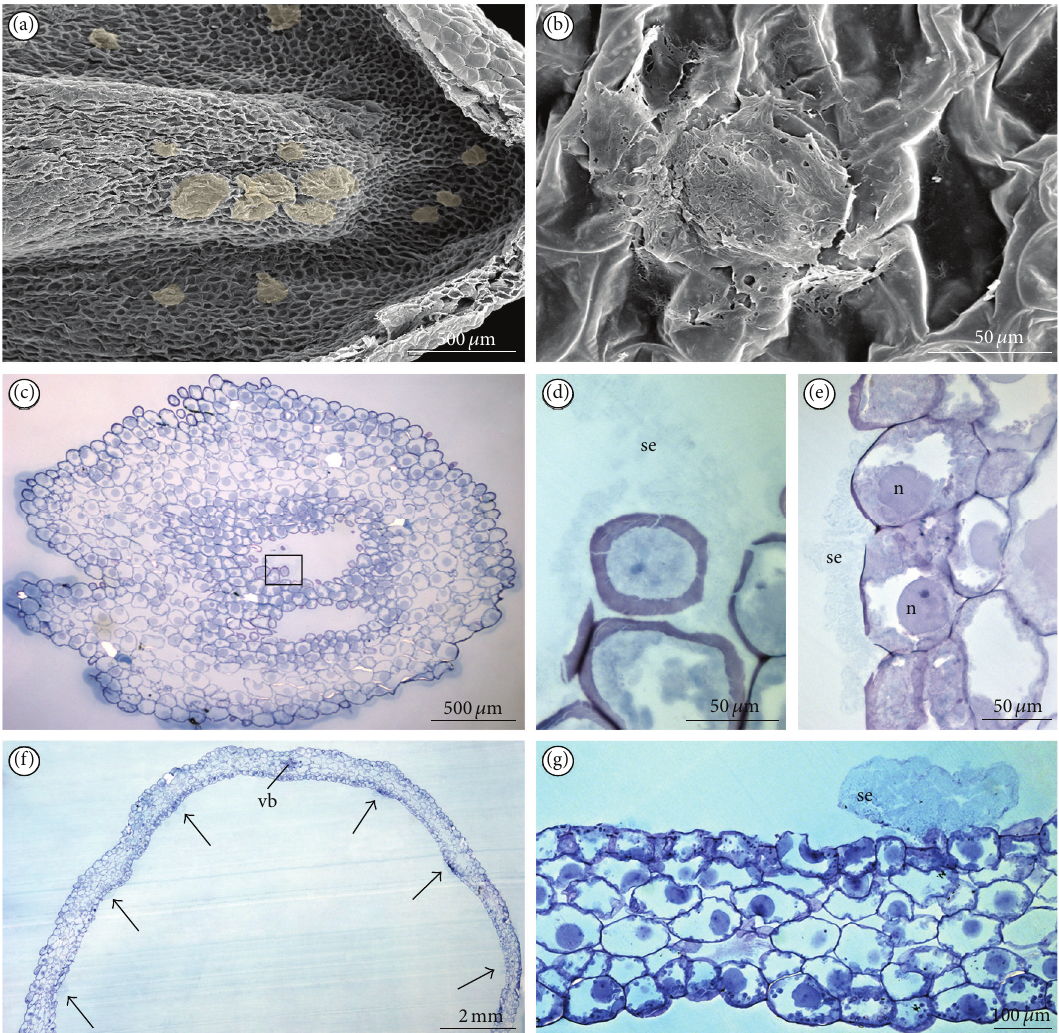
Figure 5: Lip spur, 4th day of anthesis: (a) surface of adaxial (inner) part of spur with places of secretion ( yellow ) (SEM). (b) Secretion in the apex of the spur (SEM). (c) Cross-section of spur, the apex of the spur with secretion (TBO). (d) Magnification of (c), secretion (TBO). (e) Further part of spur with visible secretion, large nuclei in dense cytoplasm (TBO). (f) Cross-section of the middle part of spur, the places with exudation ( arrows ) (TBO). (g) Large amount of the secretion inside spur, stained for proteins (ABB) (se: secretion).